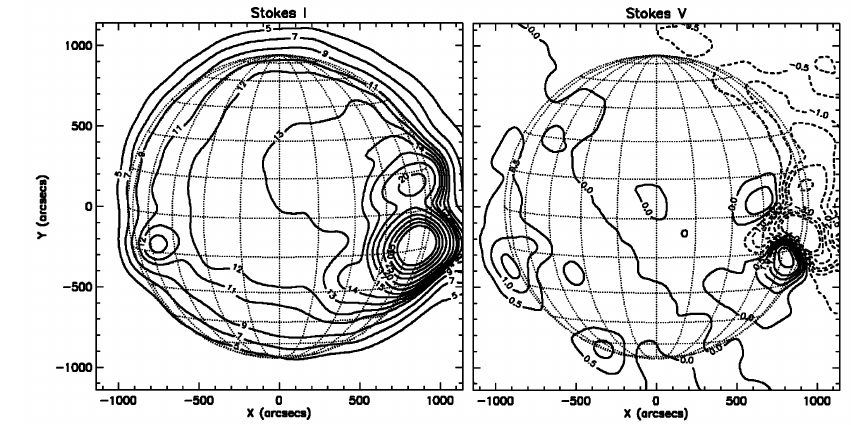
Fig. 3. Stokes I and V parameter maps of solar emission at 3.76 cm wavelength on 2012-07-17 UT 7:15. Levels are presented in 10 3 K. Solid lines on the Stokes V map are for right polarization, dashed lines are for left